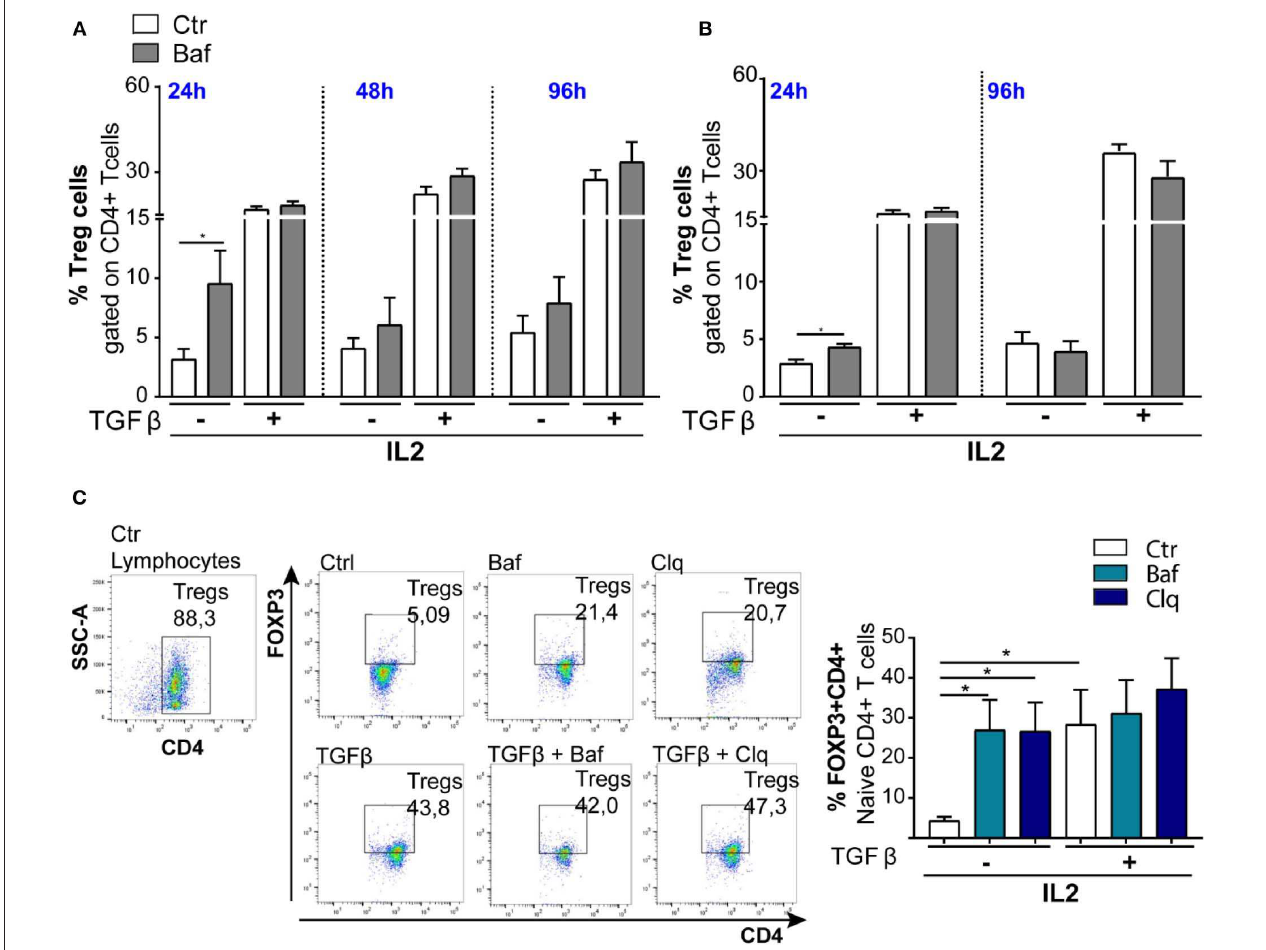
FIGURE 5 | Induction of Tregs with TGF β (2ng/ml) in wt mice ( n = 3): The bar graphs represent % of Tregs (CD4 + FOXP3 + ) analyzed by flow cytometry. The experiments were conducted at different times, 24, 48, and 96h, by culturing CD4 + T cells (A) and naïve CD4 + T cells (B) in the presence of IL2, treated or not with TGF β and stimulated with plate-bound anti-CD3 and anti-CD28. (C) Representative dot plots of FOXP3 + induction from three animals. * P < 0.05, by unpaired t -test,